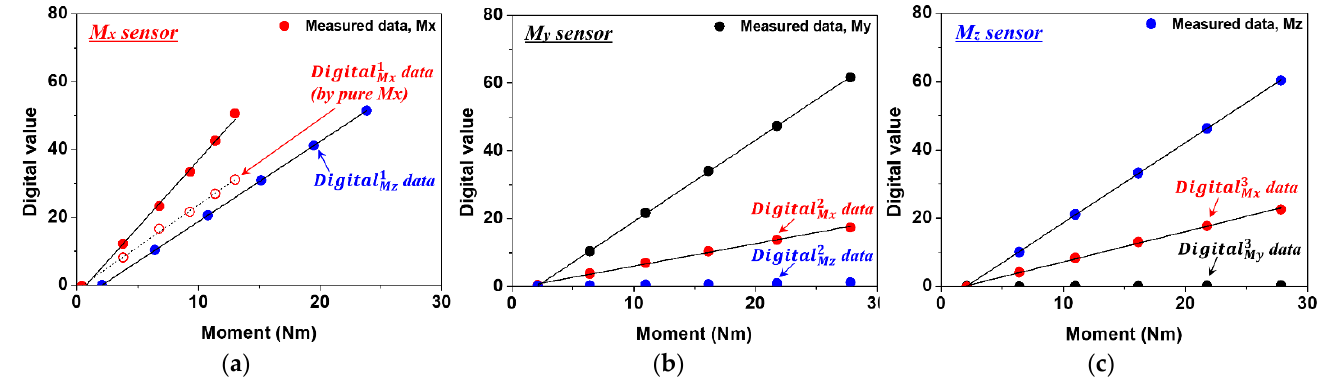
Figure 6. Calibration curve of three-axis sensor obtained through static load evaluation equipment. ( a ) Sensor data measured by Mx sensor. ( b ) Sensor data measured by My sensor. ( c ) Sensor data measured by Mz sensor.